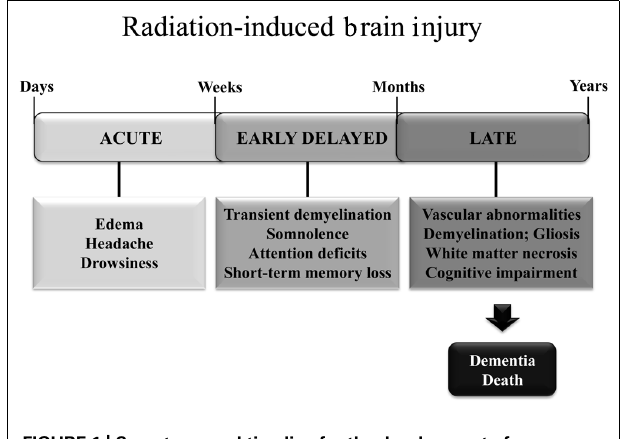
FIGURE 1 | Symptoms and timeline for the development of radiation-induced brain injury in patients treated with